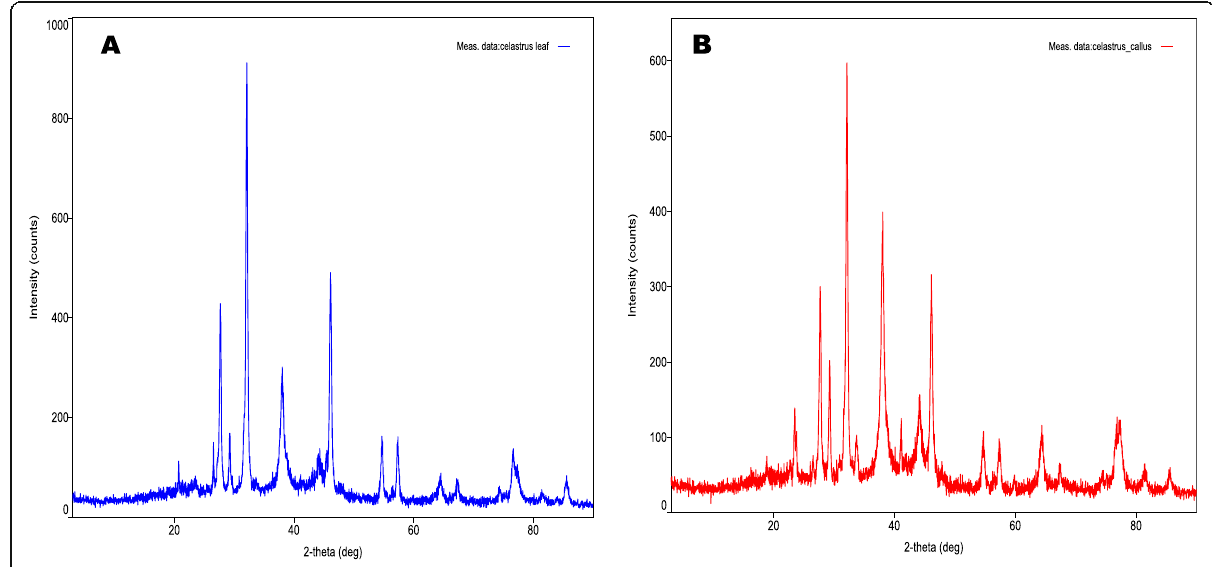
Fig. 5 XRD analysis of a leaf extract and b Callus extract plotted by theta (degree) versus intensity (counts)